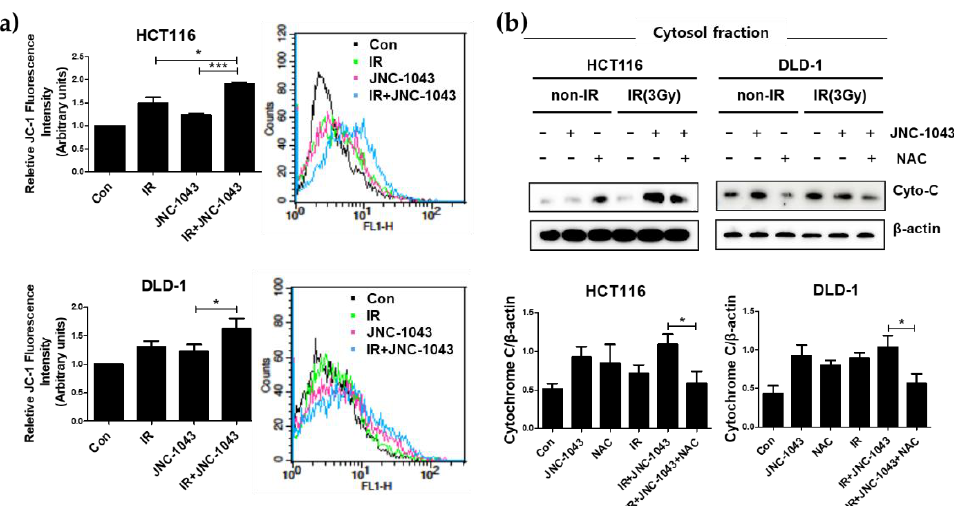
Figure 7. Co-treatment with JNC-1043 and IR disrupts mitochondrial potential. ( a ) HCT116 and DLD-1 cells (5 × 10 5 ) were treated with or without 110 or 150 nM JNC-1043, exposed to 3 Gy IR and incubated for 24 h prior to harvest. ‘Con’, mock control; ‘IR’, treatment with 3Gy IR only; ‘JNC -104 3′ , treatment with 110nM or 150nM JNC- 1043 only; ‘IR+JNC -104 3′ , combination of 3 Gy IR and110nM or 150nM JNC-1043. Mitochondrial potential in JNC-1043 and irradiation co-treated HCT116 and DLD-1 cells were detected with a FACSort flow cytometer. Experiments were repeated in triplicate, and the results indicated the mean of triplicate assays. ( b ) Immunoblot assay for detecting the release of cytochrome c from mitochondria to cytosol. JNC-1043 and IR co-treated CRC cells for 72 h with or without NAC pre-treatment for 2 or 1 h, respectively. HCT116 and DLD-1 cells (3 × 10 5 ) were incubated with or without 110 or 150 nM JNC-1043 and exposed to 3 Gy IR for 48 h. Detail assay methods are described in the Material and Methods. Each graph under the panel indicates the statistical analysis of the immunoblot bands. The relative band densities were determined via densitometry using ImageJ software (NIH, Bethesda, MD, USA) and then normalized to that of each control. Experiments were repeated in triplicate, and bands in the figures show representative data. *; p < 0.05, ***; p < 0.001.